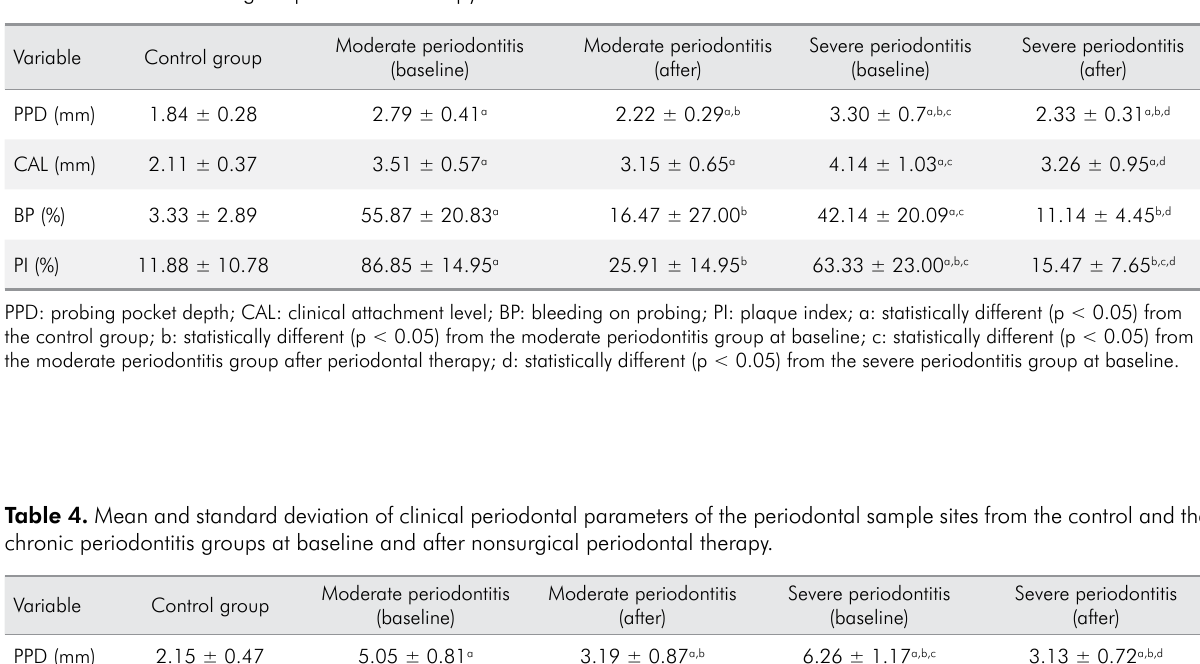
Table 3. Mean and standard deviation of clinical periodontal parameters of the control and the chronic periodontitis groups at baseline and after nonsurgical periodontal therapy.